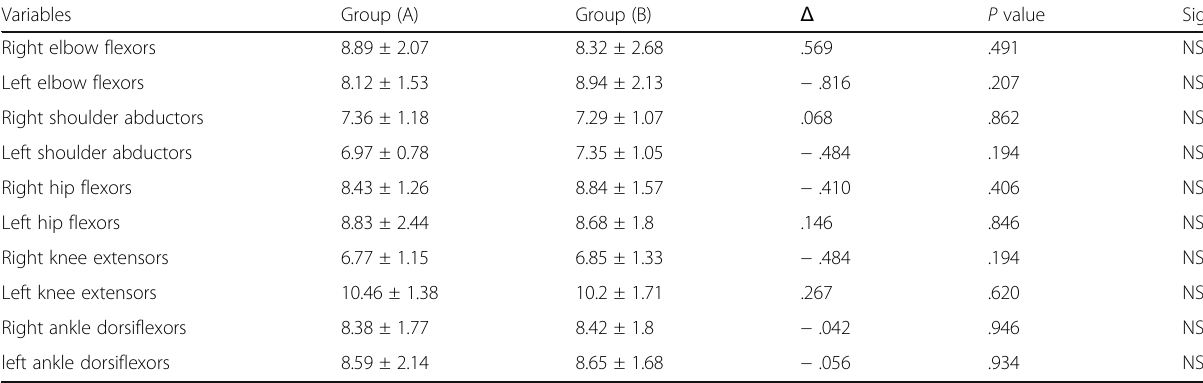
Table 4 Comparison mean value of muscle strength before treatment among groups (A and B) Variables